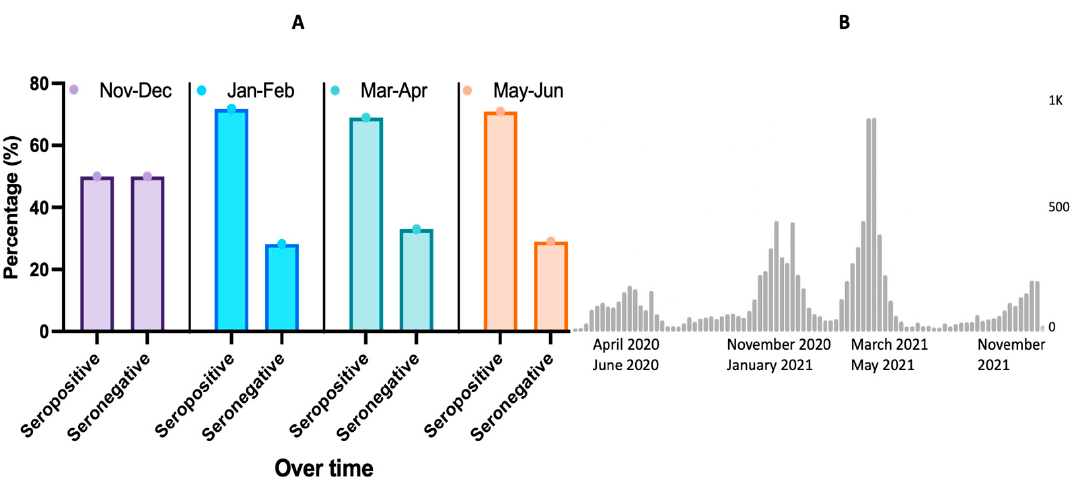
Figure 3. ( A ) Seroprevalence bimonthly trend from November 2020 to June 2021 and ( B ) waves of SARS-CoV-2 cases in Mali.